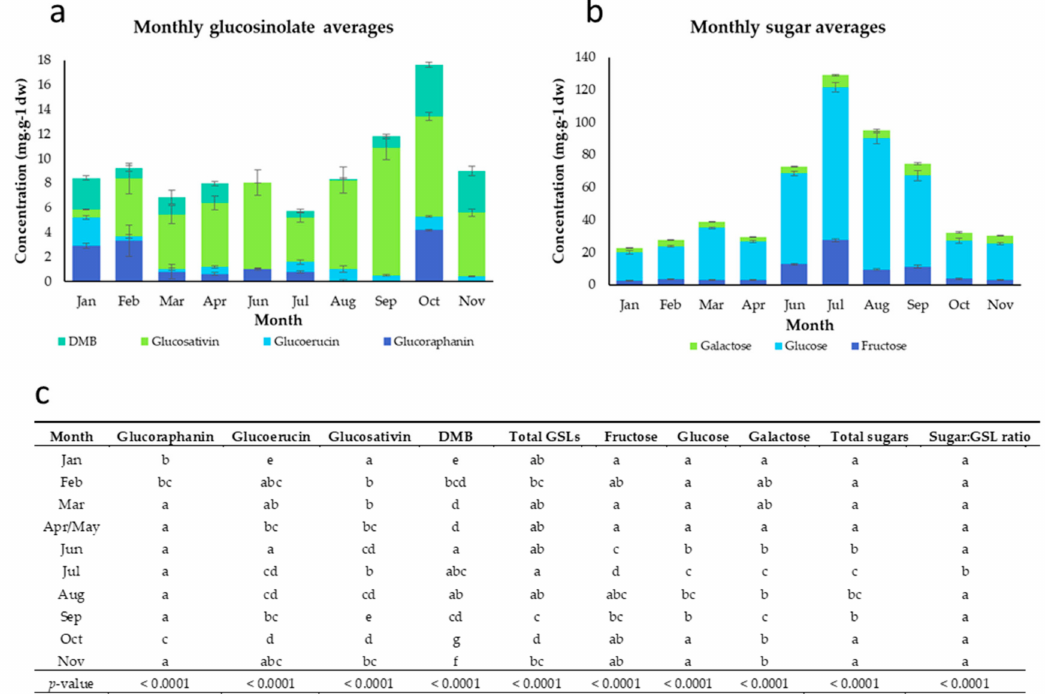
Figure 1. Average glucosinolate concentrations ( a ), sugar concentrations ( b ), and analysis of variance (ANOVA) pairwise comparisons (post-hoc Tukey’s honest significant di ff erence; ( c ) of rocket leaves observed on a monthly basis. Significant di ff erences of glucosinolate concentrations between each sampling month are indicated by di ff ering lower case letters within each column. Concentrations are expressed as mg · g − 1 of dry weight. Error bars represent standard error of the mean of each compound. See insets for compound colour coding ( a , b ). For individual cultivar composition data of samples received each month see Supplementary Data File